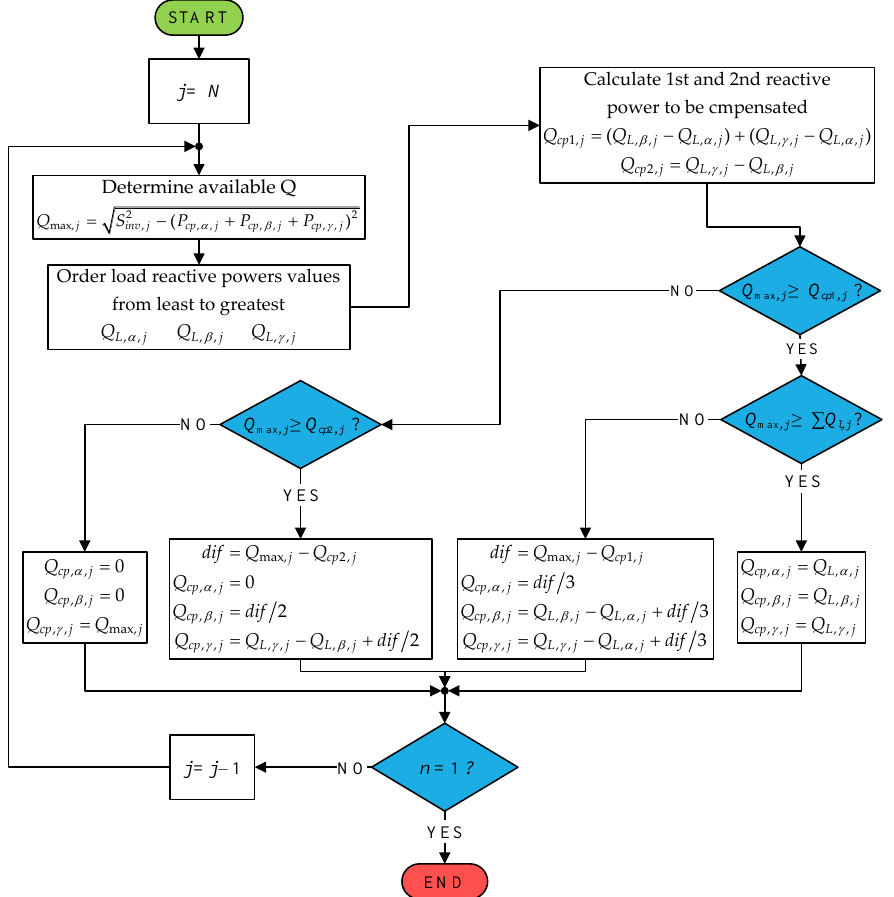
Figure 4. Flowchart for the reactive power compensation algorithm.